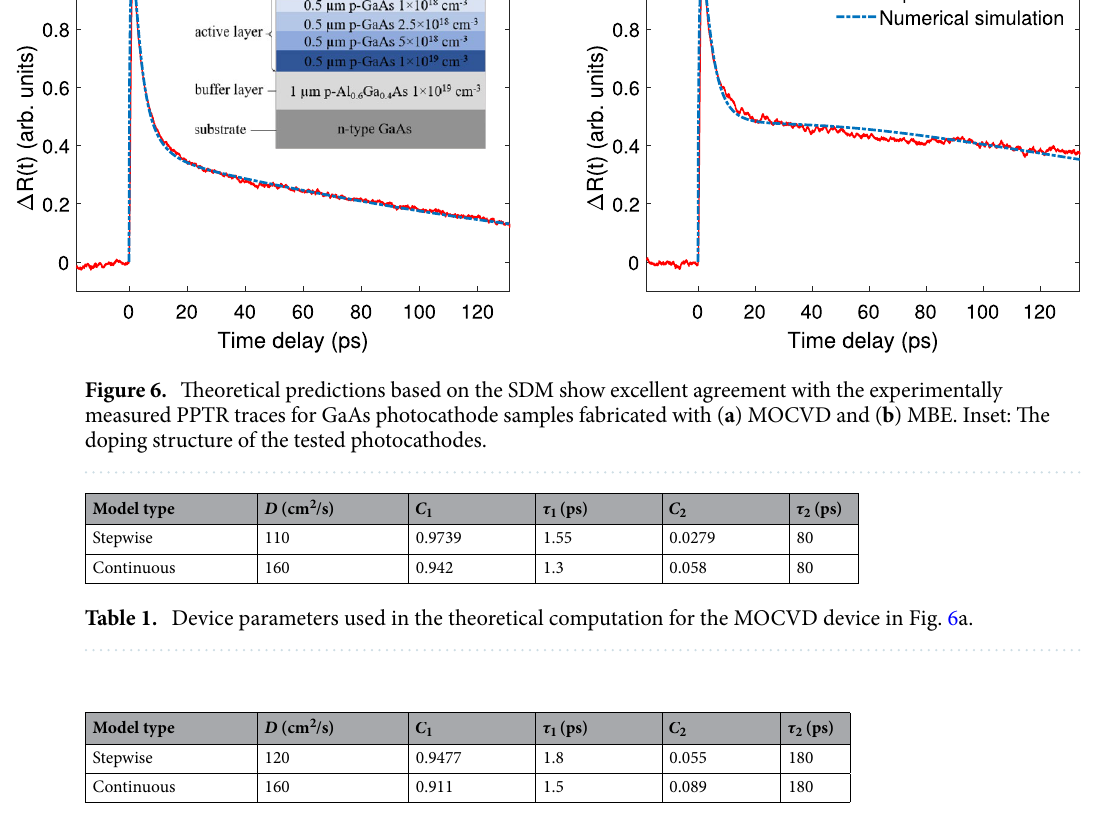
Table 2. Device parameters used in the theoretical computation for the MBE device in Fig.